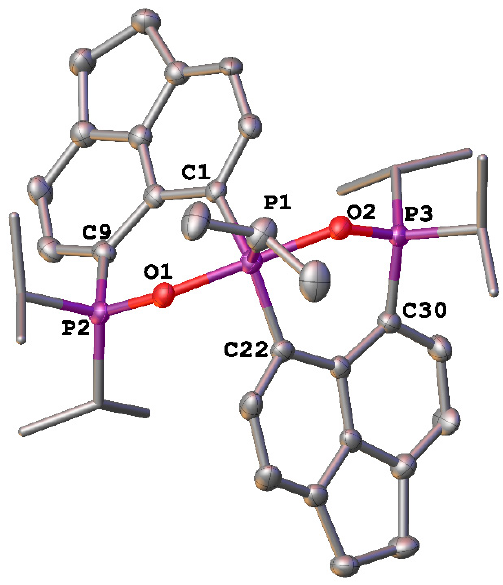
Figure 1. Molecular structure of 2 [I] 2 in the crystal. Anions (2I − ) and solvent molecules (2 CH 3 CN) were omitted, and the iPr groups are shown in the wireframe for clarity. Selected bond lengths (Å), angles, and torsion angles (°): P1-O1 1.797(3), P1-O2 1.818(3), P2-O1 1.554(3), P3-O2 1.543(3), O1-P1-O2 178.60(16), C1-P1-C22 130.7(2), P1-C1 ∙∙∙ C9-P2 22.2, P1-C22 ∙∙∙ C30-P3 21.5.